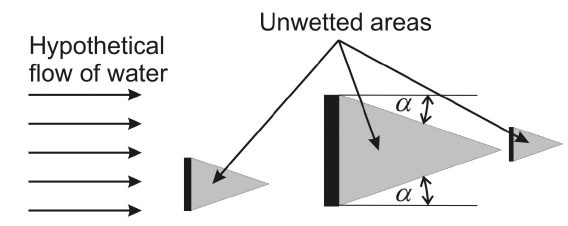
Figure 7. Illustration of the water flow algorithm in direction from left to right (black regions represent text objects i.e. , three I letters).